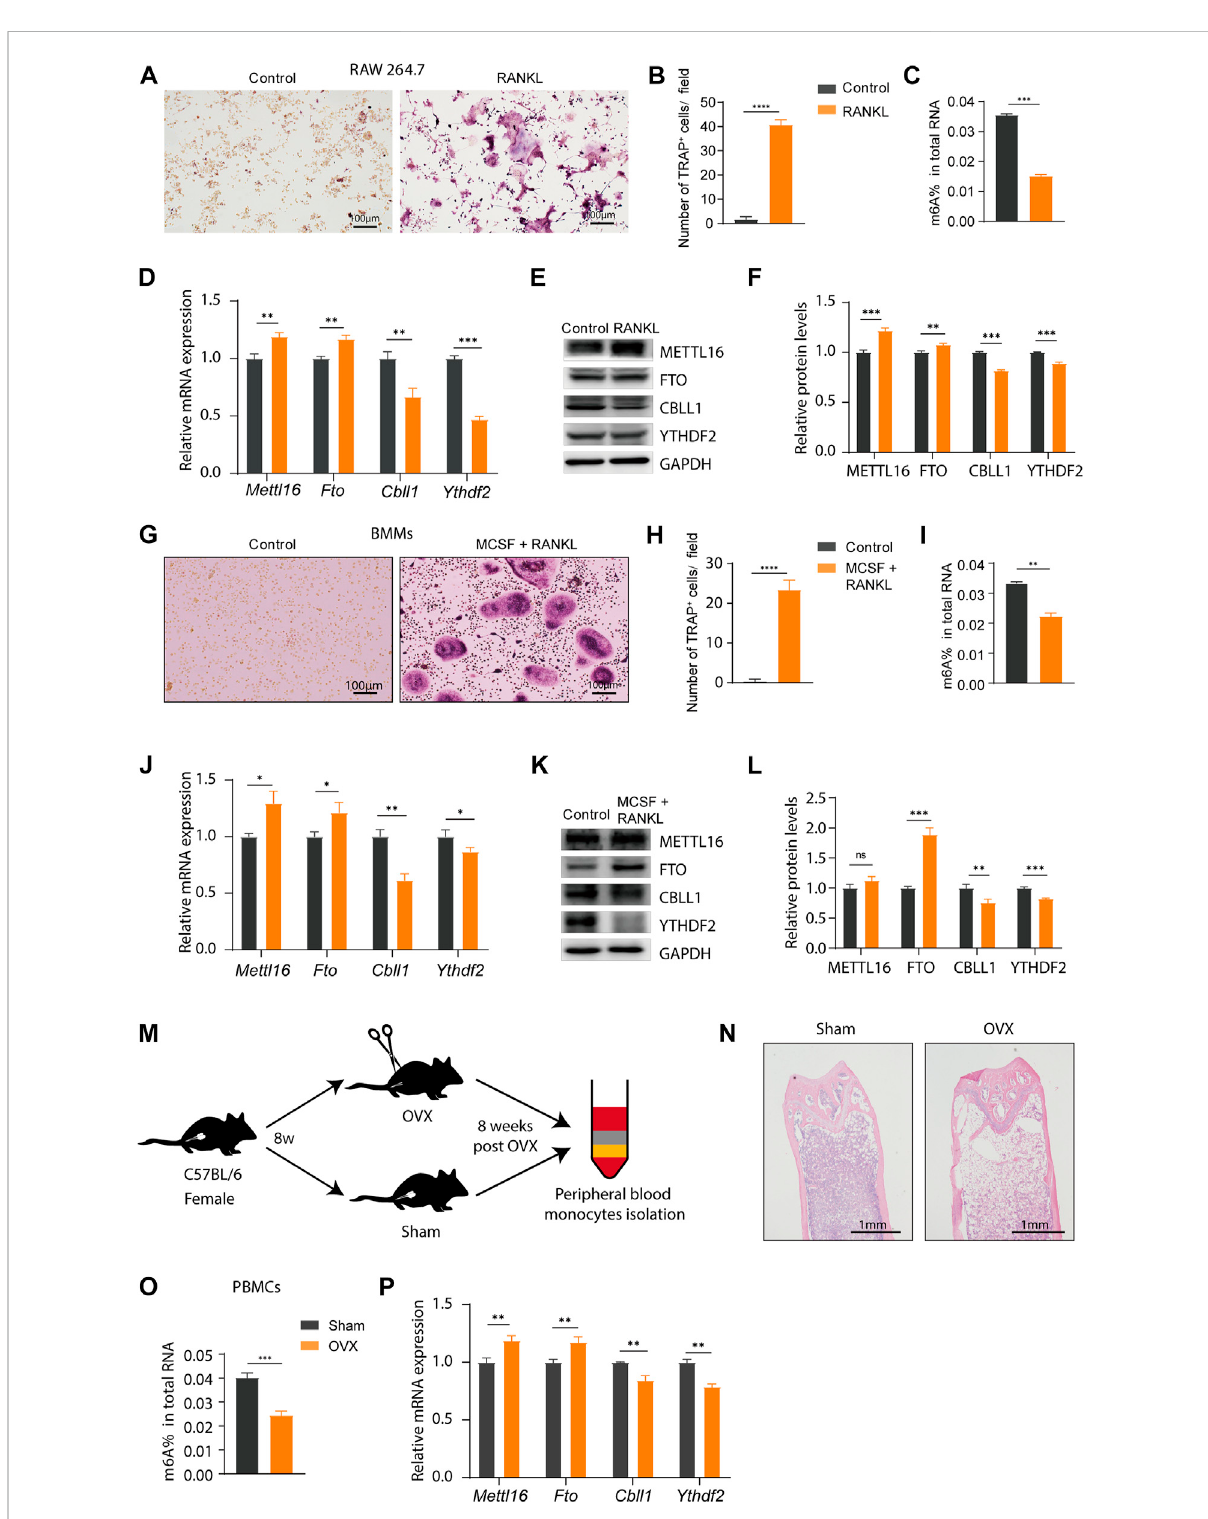
Validation of the expression of the key m6A regulators in vitro and in vivo . (A,B) Tartrate-resistant acid phosphatase (TRAP) staining and TRAP + multinuclear cells counting of RAW 264.7 cells with or without nuclear factor (NF)- κ B (RANKL) stimulation. Scale bar, 100 μ m. (C) The m6A level in total RNA isolated from RAW264.7 cells during the osteoclast differentiation. (D) The expression of Mettl16 , Fto , Cbll1 , and Ythdf2 in RAW264.7 cells was detected by real-time PCR after cultured with RANKL for 4 days (E,F) Western blotting and quanti fi cation of METTL16, FTO, CBLL1